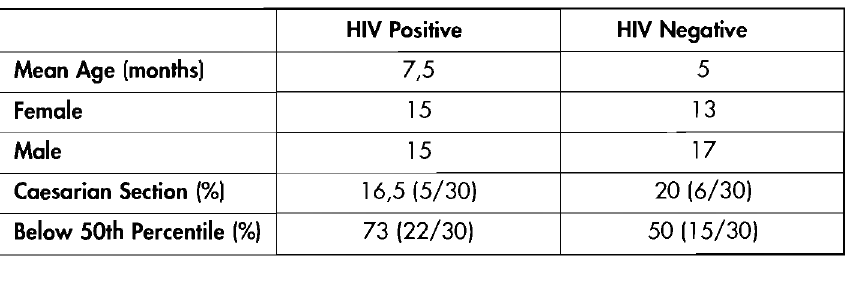
Table 1: Summary of Demographic Data of the Experimental and Control Groups